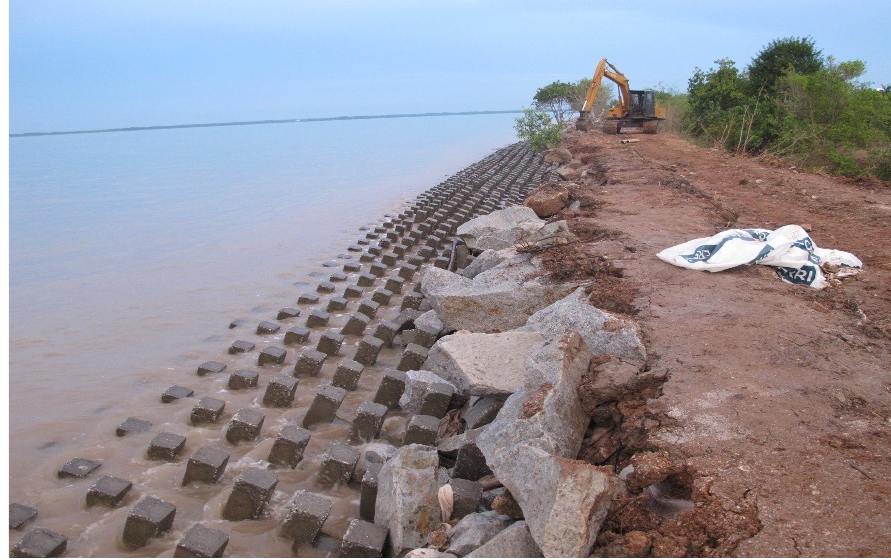
Figure 1. Photo showing SAUH installed at Sungai